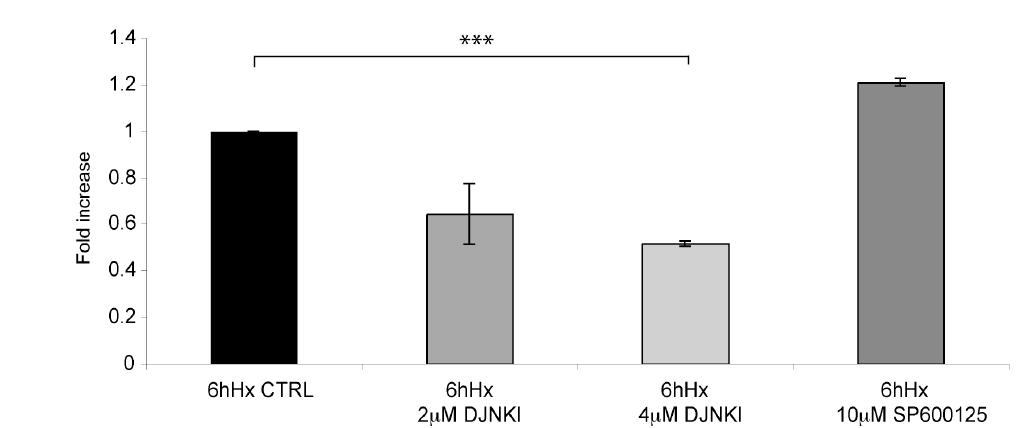
Figure 5. D -JNKI1 treatment rescues neurons from hypoxic induced death. D